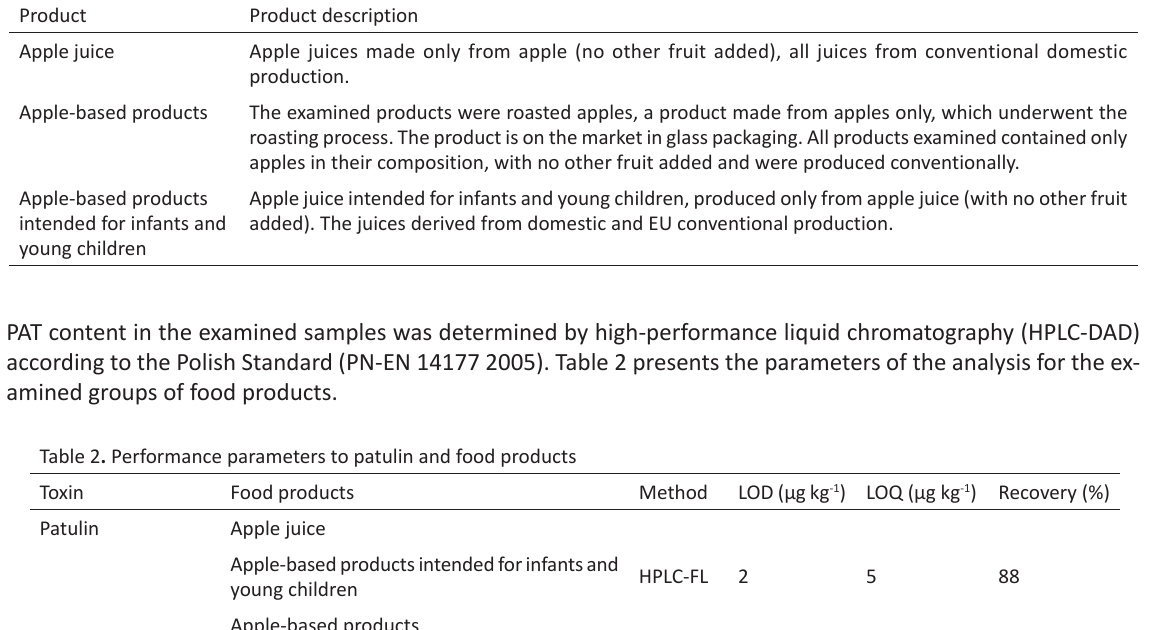
Table 1. Characteristics of the examined products